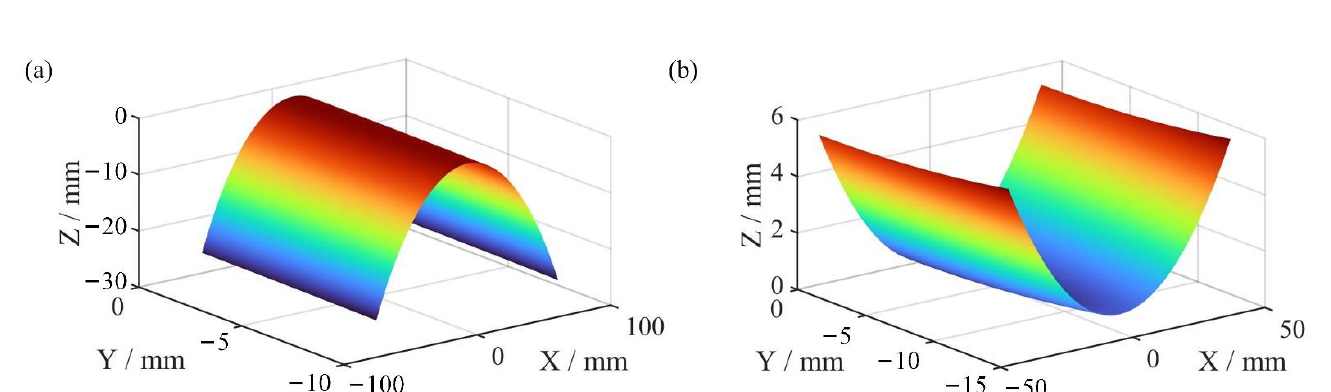
Figure 10. Surface maps: ( a ) PM , ( b ) SM .